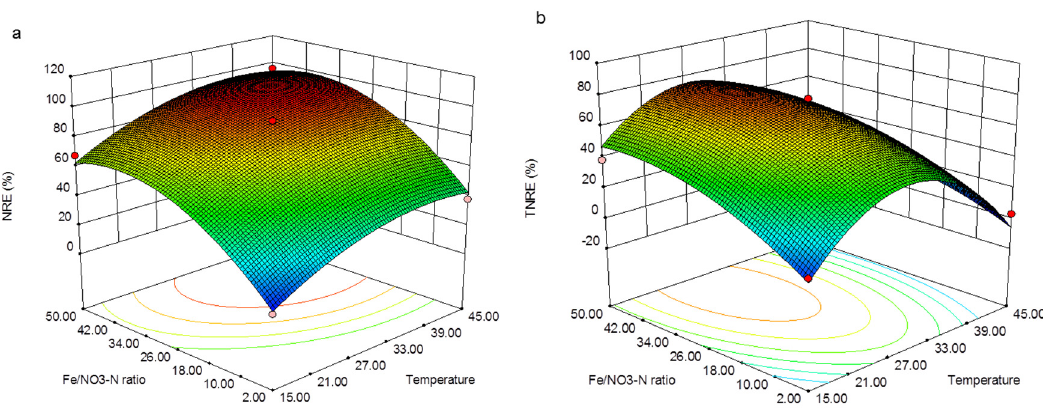
Figure 5. Response 3D-surface plots of ( a ) NRE and ( b ) TNRE at different Fe/NO 3 -N ratio versus temperature.